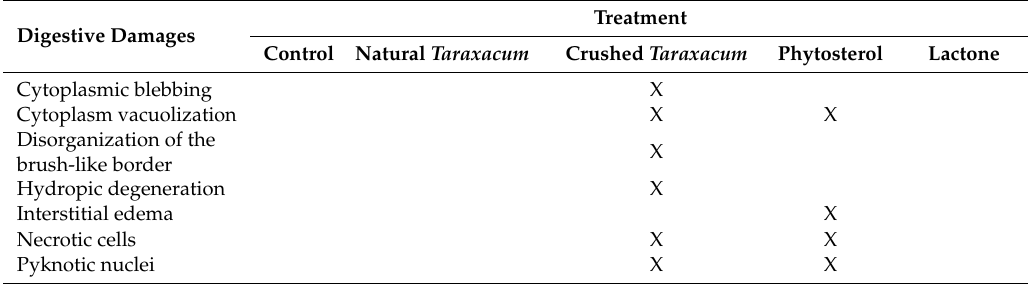
Table 1. Signs of histopathological alterations in the digestive tract of B. terrestris workers fed various diet